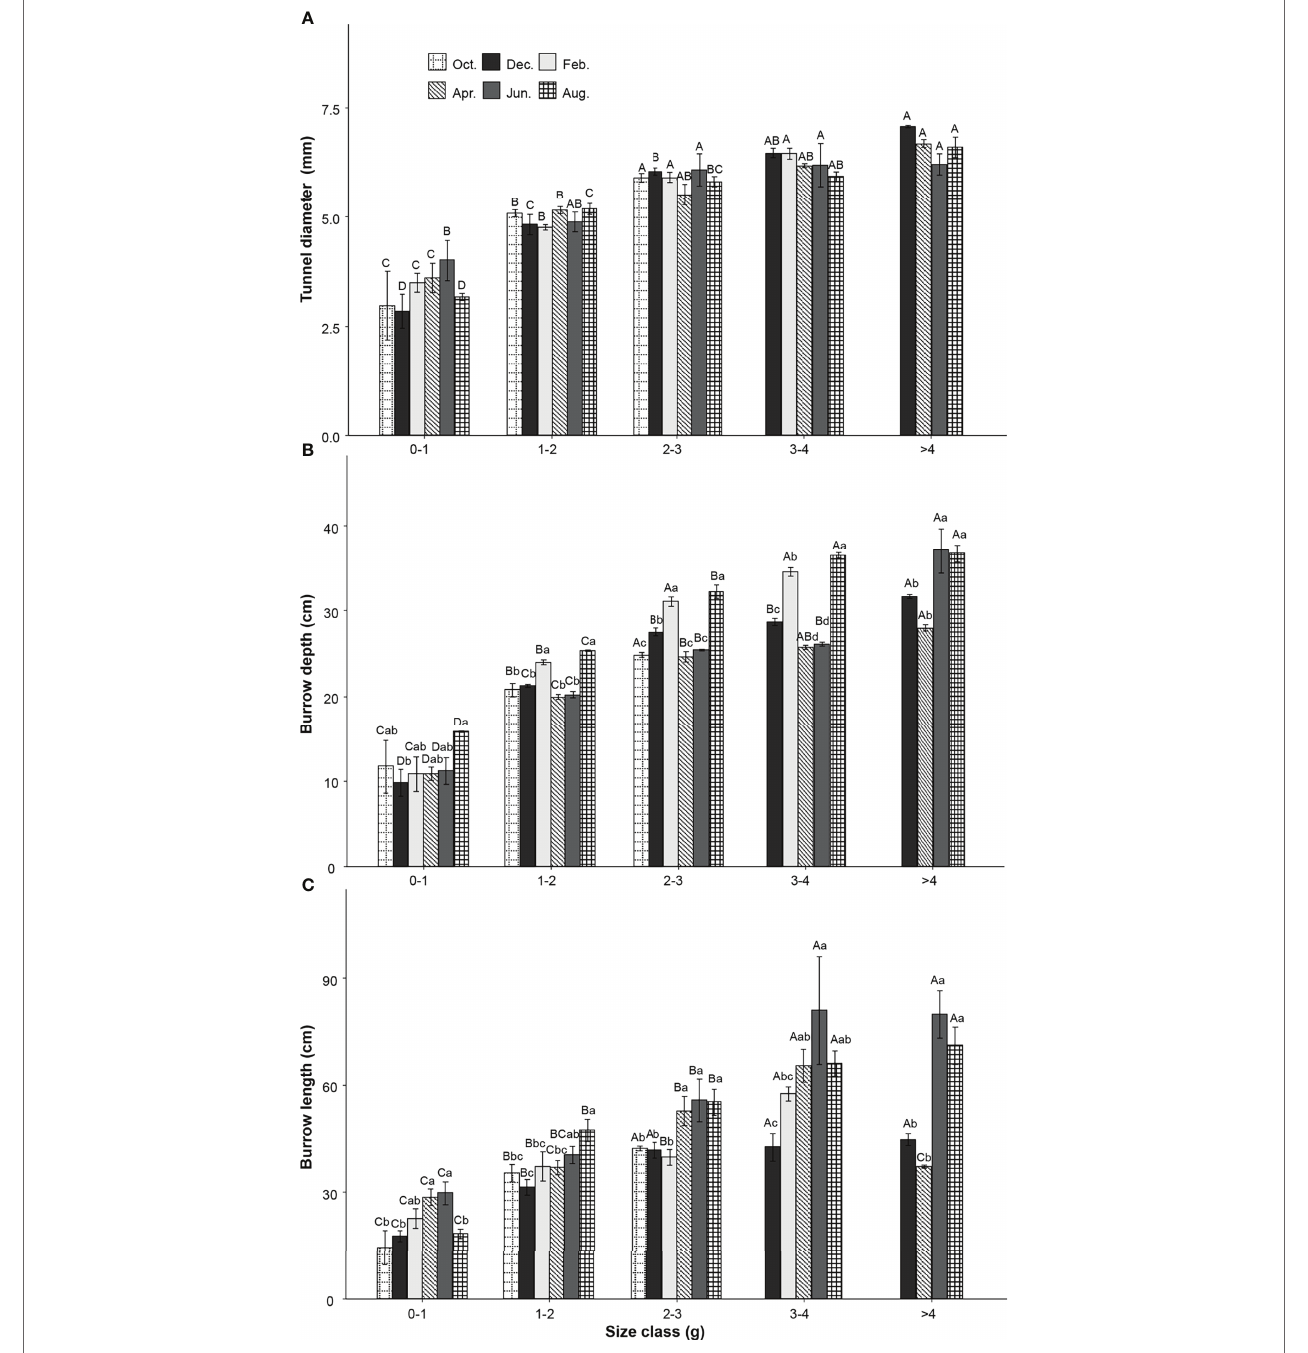
FIGURE 4 | Variation of P. aibuhitensis tunnel diameter (A) , burrow depth (B) , burrow length (C) with size class and sampling month. Different capital letters represent significant differences between size classes with the same month ( P < 0.05). Different lowercase letters represent significant differences between sampling months within the same size class ( P < 0.05). Error bars represent